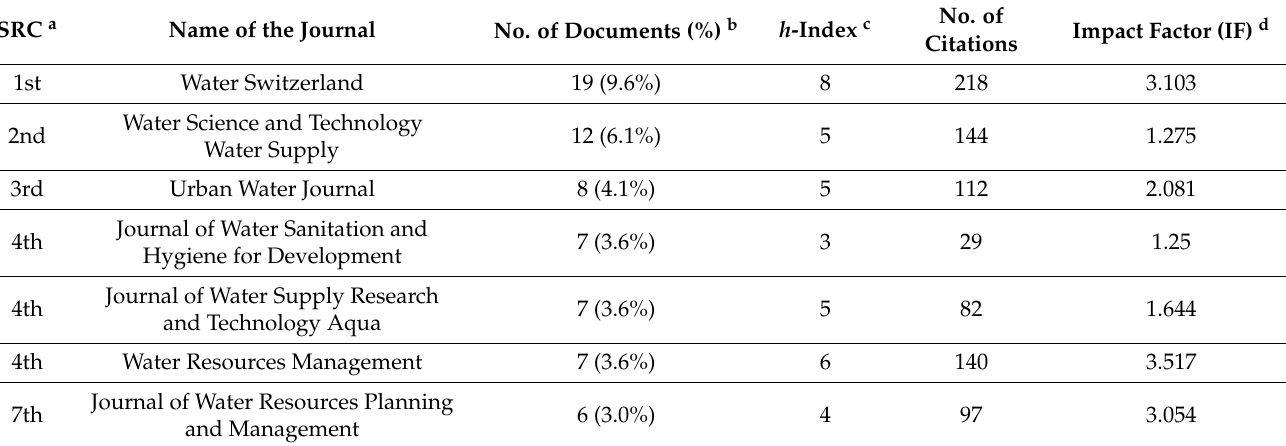
Table 2. List of top 10 most-prolific journals on intermittent water supply systems